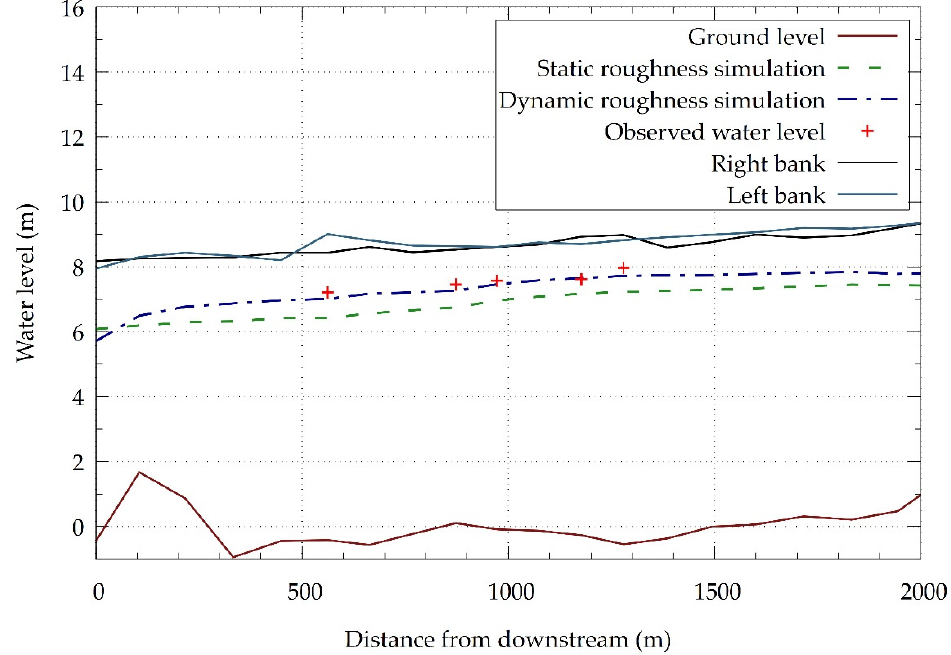
Figure 10. Simulated water level profiles of the simple Manning roughness coefficient setting simulation and the dynamic Manning roughness coefficient calculation simulation.